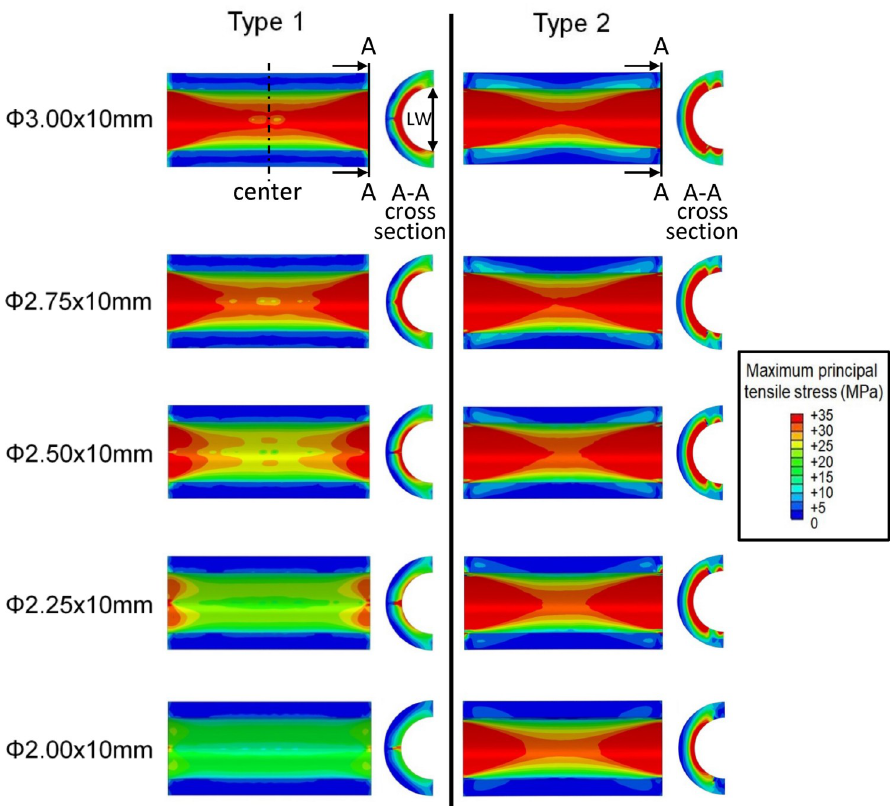
Fig 3. Stress distributions in the calcified artery models for Type 1 and Type 2 at rated pressure (12 atm) with five different balloon diameters. The cross-sectional stress distributions in the thickness-wise direction were at the longitudinal end of the calcification models. The location of label “A-A” is the longitudinal end of the calcification. The label “LW” denotes the lumen width of calcification at the longitudinal end at balloon inflation. https://doi.org/10.1371/journal.pone.0251404.g003 atm. All the cross-sections were drawn at the longitudinal end positions of the artery models connected with the calcification models where the peak values occurred. In Fig 6A, the peak